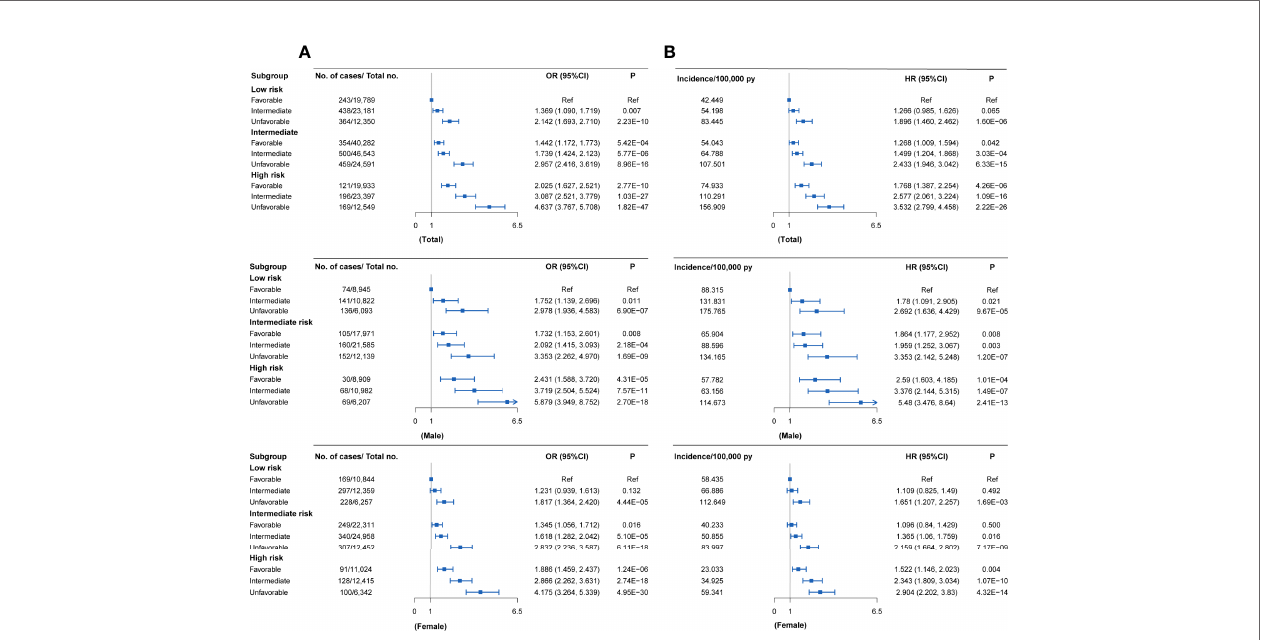
FIGURE 4 | RA risks in the subgroups strati fi ed by genetic PRSs and lifestyles in the UKB cohort (versus participants with favorable lifestyles in the low genetic risk group) (A) Case-control study; (B) Cohort study. De fi nition of healthy lifestyle indicators: include 0 to 1 healthy lifestyle indicator for unfavorable lifestyle, 2 for moderate lifestyle, and all 3 for favorable lifestyle. The genetic risk groups were evaluated by PRS: low genetic risk (bottom quartile of PRS), intermediate genetic risk (quartiles 2 to 3), and high genetic risk (top